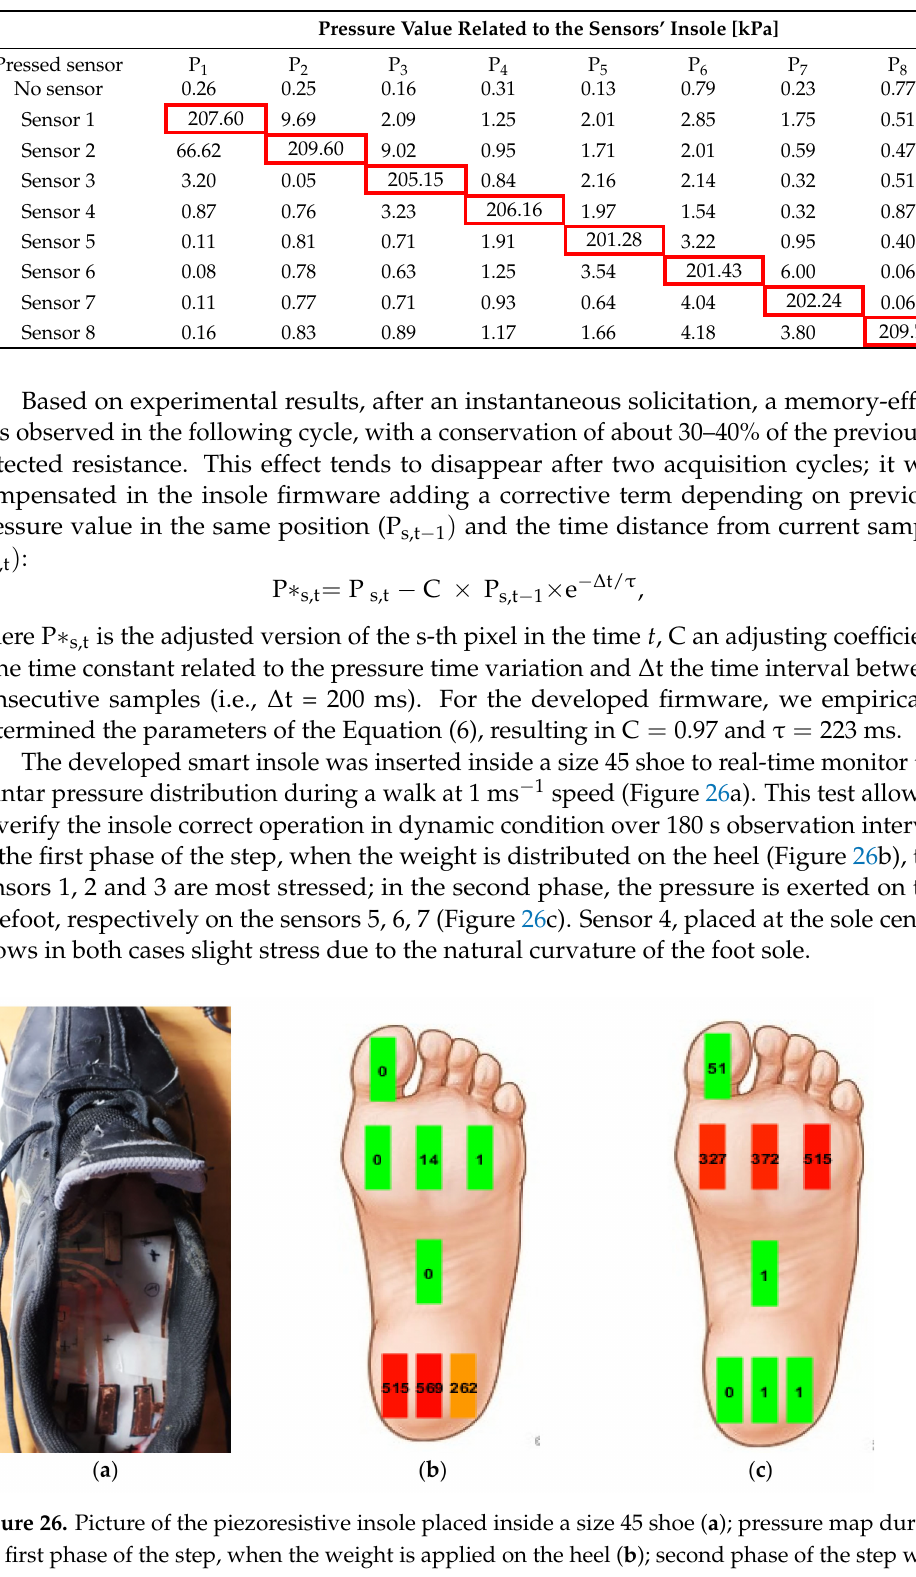
Table 4. Carried out tests applying 200-kPa load on one sensor at a time of the sensing matrix.